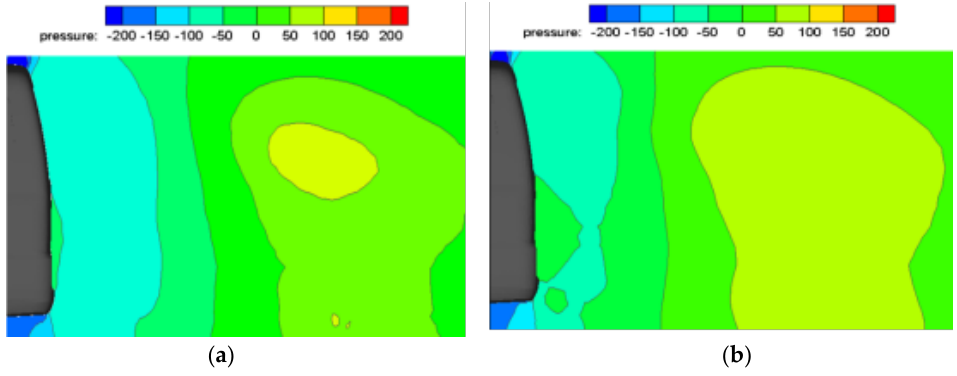
Figure 15. (a) Wake pressure contours comparison of original minivan (Pa). ( b ) Wake pressure contour of the optimized minivan (Pa).